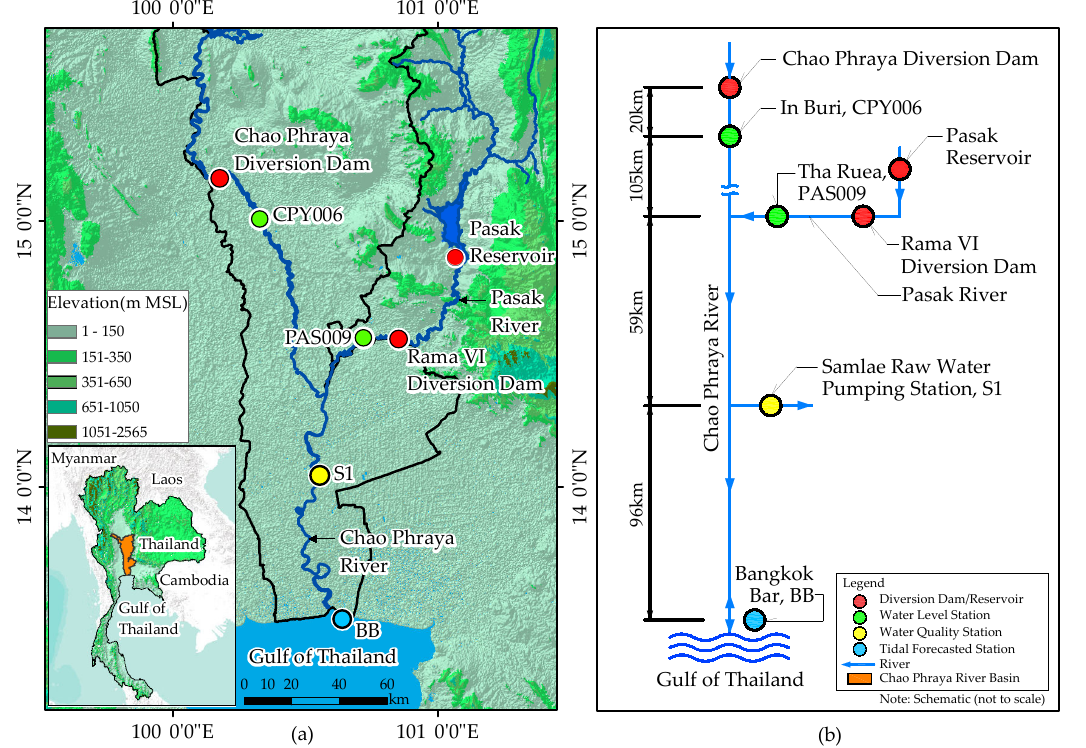
Figure 1. Map and schematic of the study site. ( a ) Geographic details of the lower Chao Phraya area, and ( b ) the schematic of the related measurement stations in this